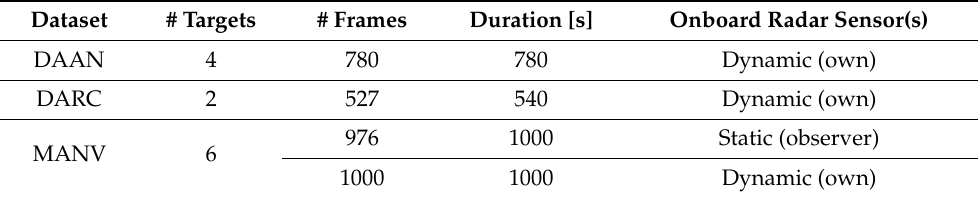
Table 1. Summary of the